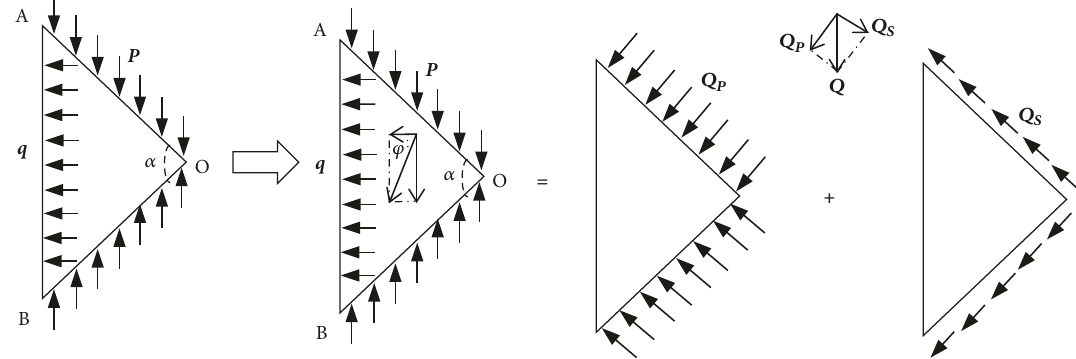
Figure 12: Analyzing the stress in the surrounding